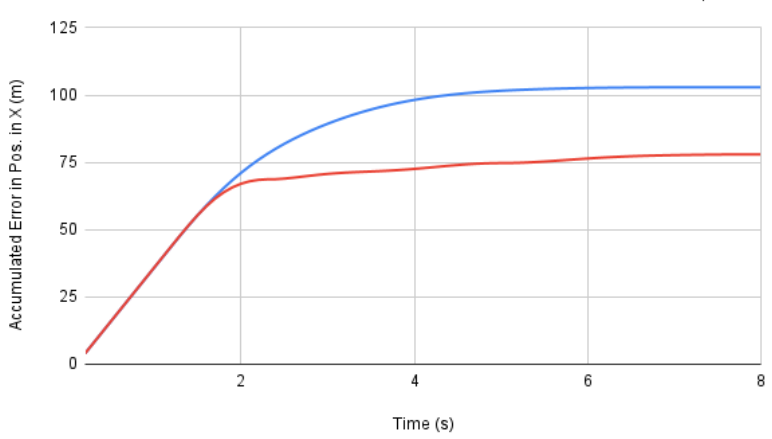
Figure 10. Accumulated Error comparison between ArduPilot and the proposed